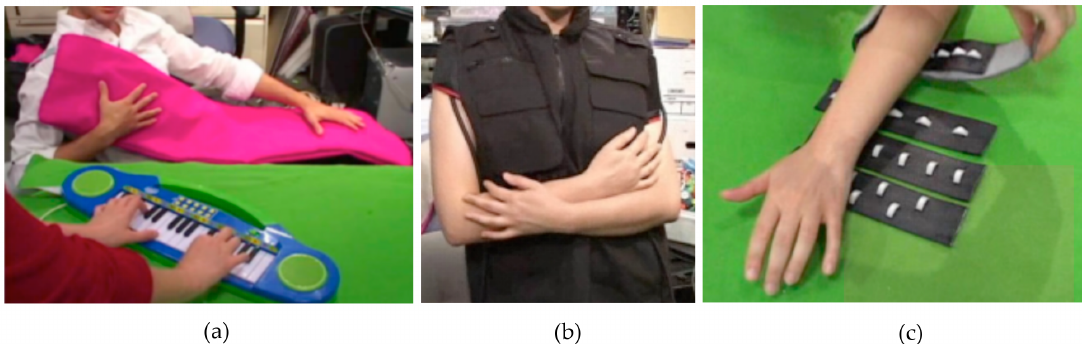
Figure 5. Various experimental haptic interfaces for therapy: ( a ) Touch Me simulates touch; ( b ) Squeeze Me simulates hugs; ( c ) Hurt Me induces controlled pain. ( c (cid:13) 2009 ACM. Reprinted with permission